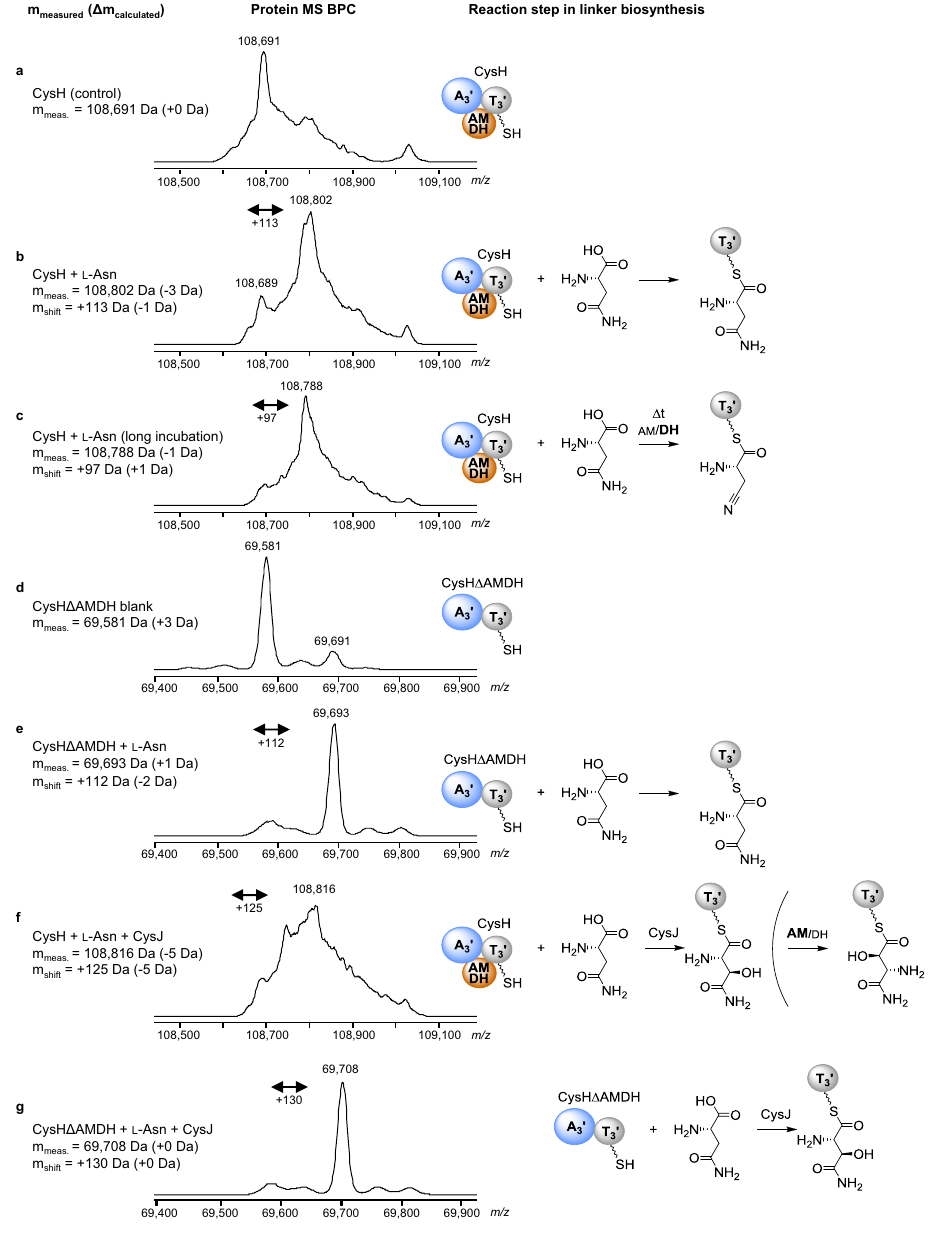
Fig. 3 Loading and hydroxylation of L -asparagine on CysH or CysH Δ AMDH. Deconvoluted protein MS BPCs (left) reveal different reaction mechanisms (models shown on the right) after in vitro incubation of CysH or CysH Δ AMDH with L -asparagine with and/or without CysJ. a CysH control. b Loading of L -asparagine onto CysH. c The dehydratase activity of the AMDH domain leads to dehydration of L -asparagine and formation of β -cyano- L -alanine after prolonged incubation times. d CysH Δ AMDH control. e CysH Δ AMDH incubated with L -asparagine. No dehydration of L -asparagine was observed since CysH has no AMDH domain. f CysH incubated with L -asparagine and CysJ leads to loading of the substrate onto CysH with subsequent hydroxylation by CysJ (see Fig. 4). The isomerization of ( β -hydroxy-) L -asparagine to ( α -hydroxy-) L -isoasparagine is shown in parenthesis because this step cannot be observed by MS. The isomerization was con fi rmed by deletion of the AMDH domain from the BGC and analysis of the production pro fi le after heterologous expression of the respective construct in M. xanthus DK1622 (see Fig. 5). g CysH Δ AMDH incubated with L -asparagine and CysJ leads only to the formation of β -hydroxy- L -asparagine. Blue sphere: adenylation domain; gray sphere: thiolation domain; orange sphere: AMDH